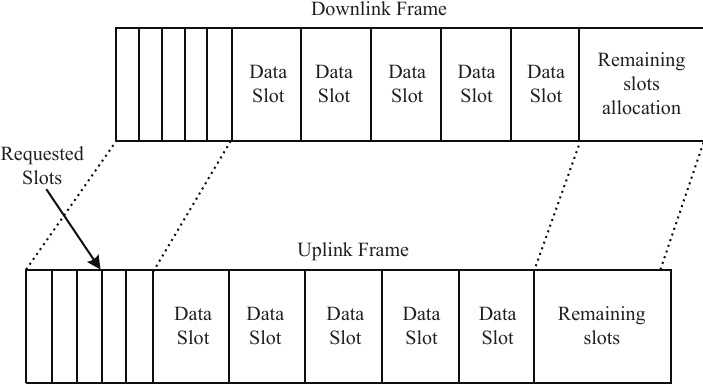
Figure 1. Frame structure of the combined free/demand assignment multiple access-gray forecast